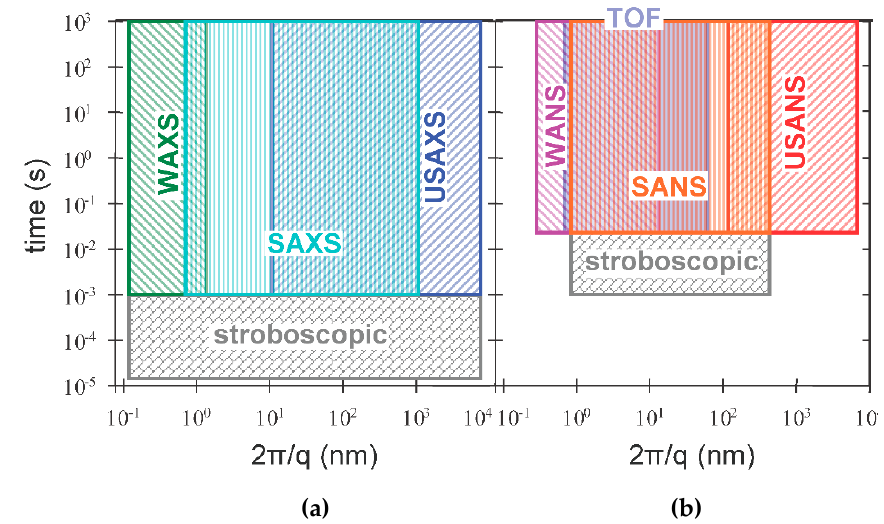
Figure 2. Time and length scale provided by small-angle X-ray and neutron scattering experiments (panel ( a ) and ( b ), respectively).